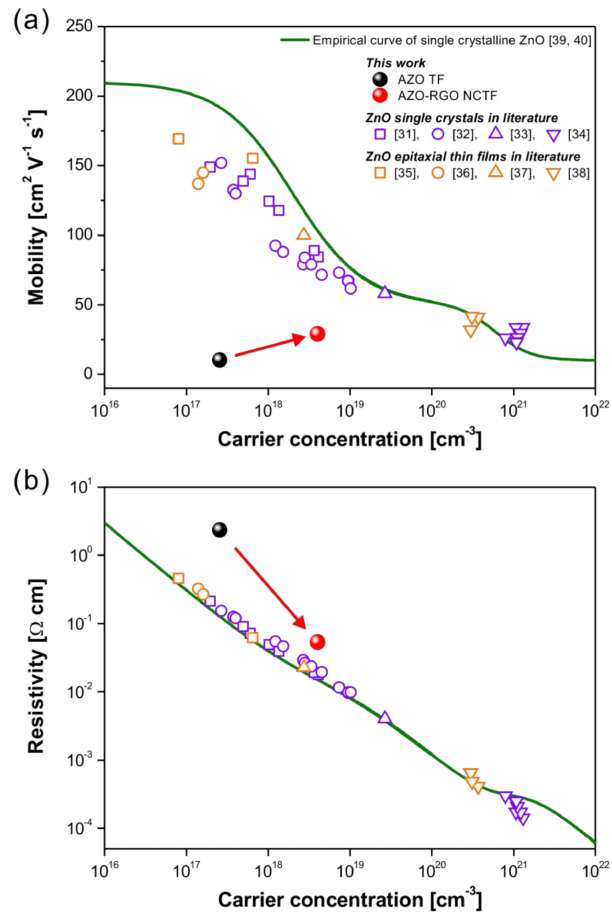
Figure 5. Carrier-concentration-dependent ( a ) mobility and ( b ) resistivity in AZO TF and AZO-RGO NCTF at room temperature. For comparison, mobility and resistivity values of ZnO single crystals [31–34] and epitaxial thin films [35–38] in the literature are also